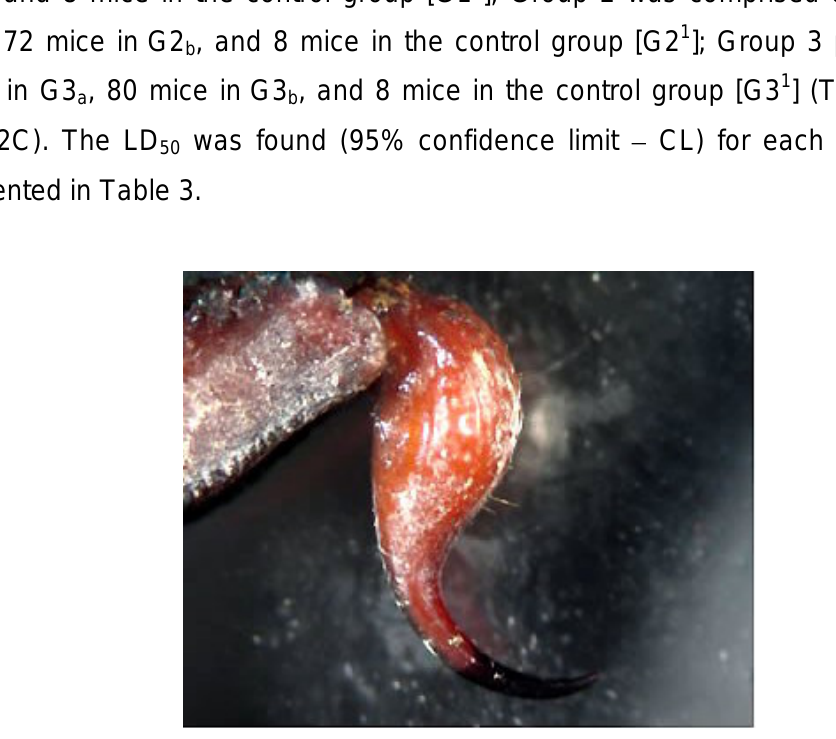
Figure 1: Telson of Androctonus crassicauda (by Ozkan O. et al . J. Venom. Anim. Toxins incl. Trop. Dis ., 2006, 12, 297-309).